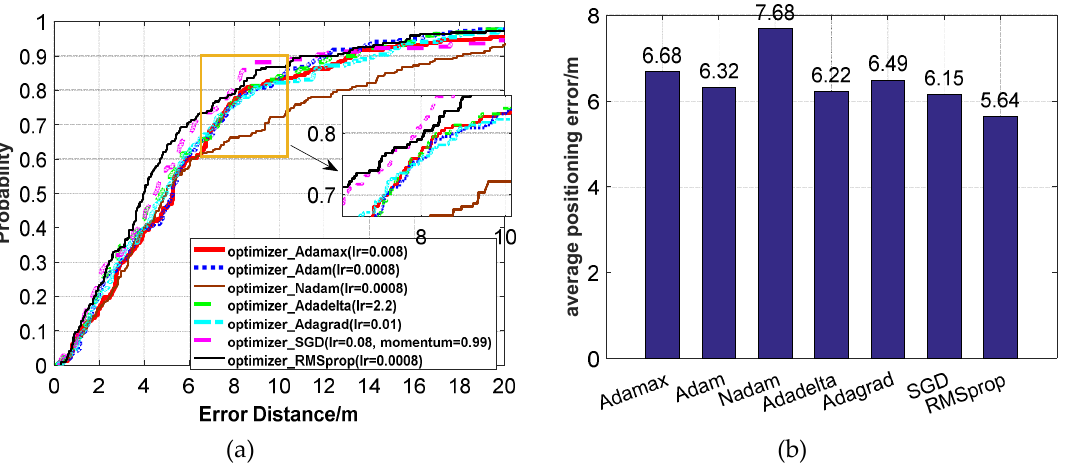
Figure 16. The positioning accuracy using different optimizers. ( a ) CDF positioning errors. ( b ) Average positioning errors.